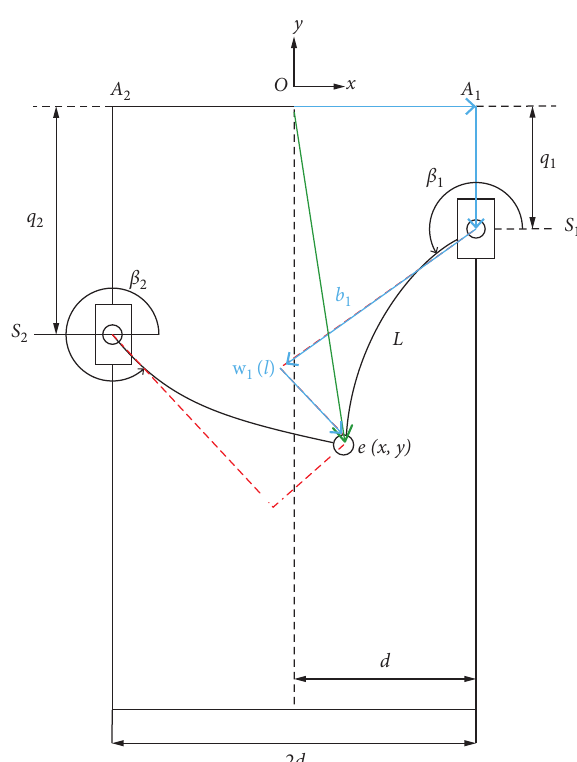
Figure 4: The closed kinematic chain of 2-PRRRP with flexible